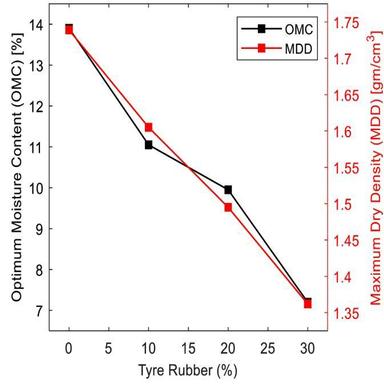
Influence of tyre rubber on MDD and OMC.